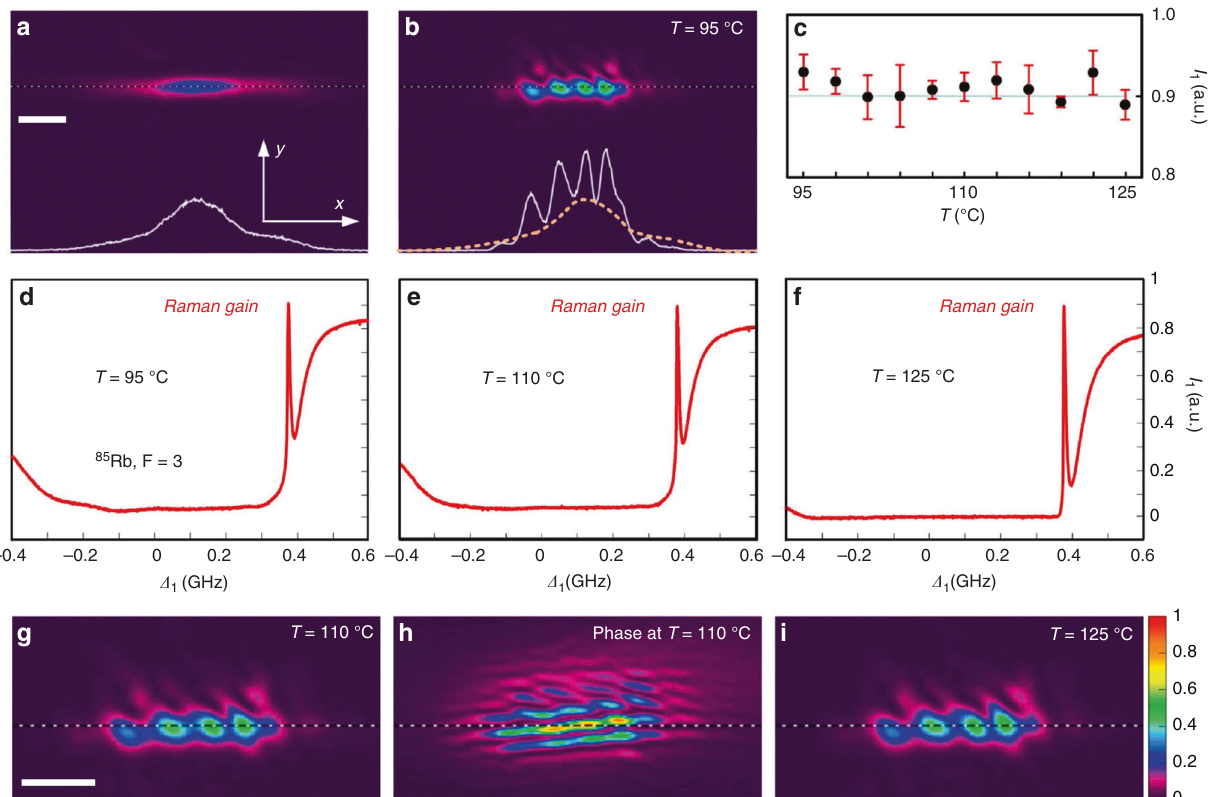
Fig. 5 Formation of edge solitons in the presence of Raman gain. a Input probe beam. Scale bar: 200 μ m. b Output probe beam in the presence of Raman gain at T ¼ 95 o C . The cross-section of the incident beam shown in both panels a and b enables comparison with the output pro fi le that con fi rms suppression of losses by Raman gain. a , b share the same scale bar. c Output probe intensity with Raman gain versus different temperatures (atomic density). Each black dot represents the peak intensity of the probe beam with Δ 1 ¼ 380 MHz , where the Raman gain locates. The error bars indicate the standard deviation for three measurements. d – f Output probe spectra versus Δ . The peak heights correspond to the dots in ( c ). Pro fi les of the output 1 probe beams in the presence of Raman gain at T ¼ 110 o C ( g ) and T ¼ 125 o C ( i ). Scale bar: 200 μ m. h Interference pattern with reference beam corresponding to ( g ). h , i share the same scale bar as ( g